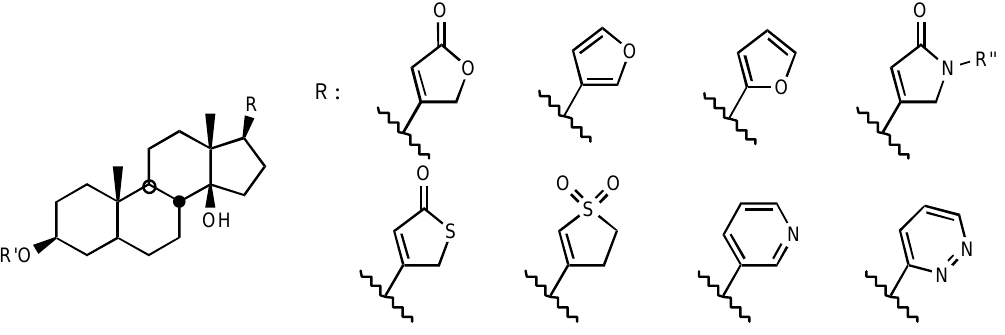
Figure 10. Semisynthetic derivatives with heterocycles replacing the lactone